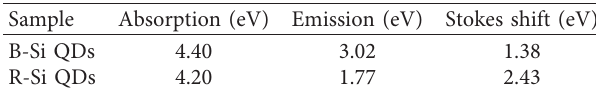
Figure 8: Tauc plot for the R-Si QDs and B-Si QDs. Table 1: Absorption and emission gaps and Stokes shift. Sample Absorption (eV) Emission (eV) Stokes shift (eV) B-Si QDs